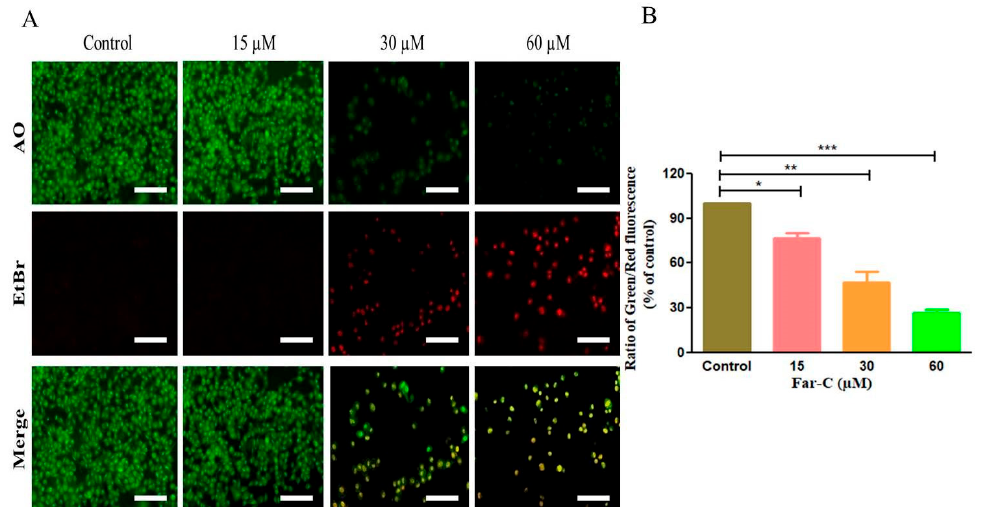
Figure 4. ( A ) Instigation of apoptotic cell death in HepG2 cells after treatment with Far-C (15, 30, and 60 µM) for 24 h and ( B ) quantification of apoptotic cell death through ImageJ software NIH, Maryland, USA, (v4). Scale bar = 100 µm. * p < 0.05, ** p < 0.01, *** p < 0.001.